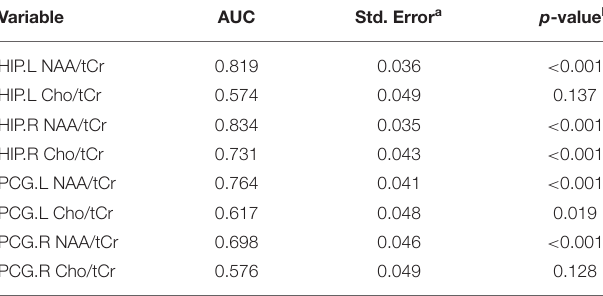
TABLE 4 | The area under the receiver operating characteristic (ROC)